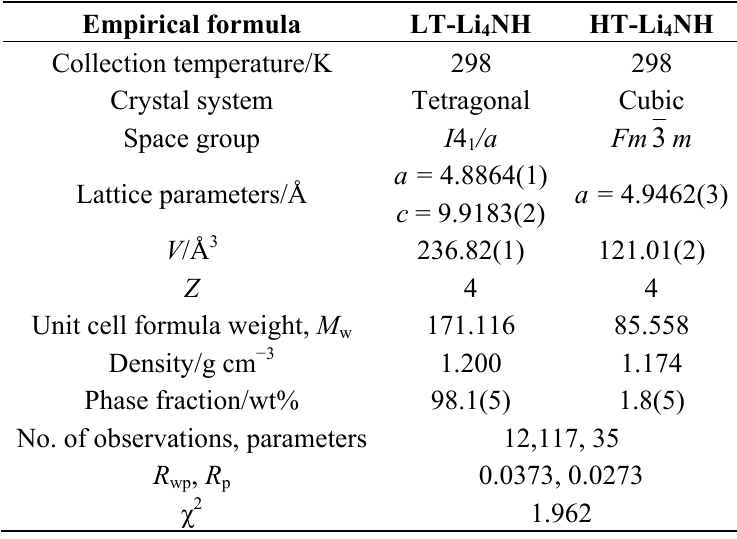
Figure 7. Observed-calculated-difference (OCD) profile plot from the room temperature Rietveld refinement for sample 8. Observed data are shown in red, calculated data are shown in green and the difference between the two profiles is shown in pink. Black NH, red tickmarks correspond to cubic Li tickmarks correspond to tetragonal Li 4 blue tickmarks correspond to SiO 2